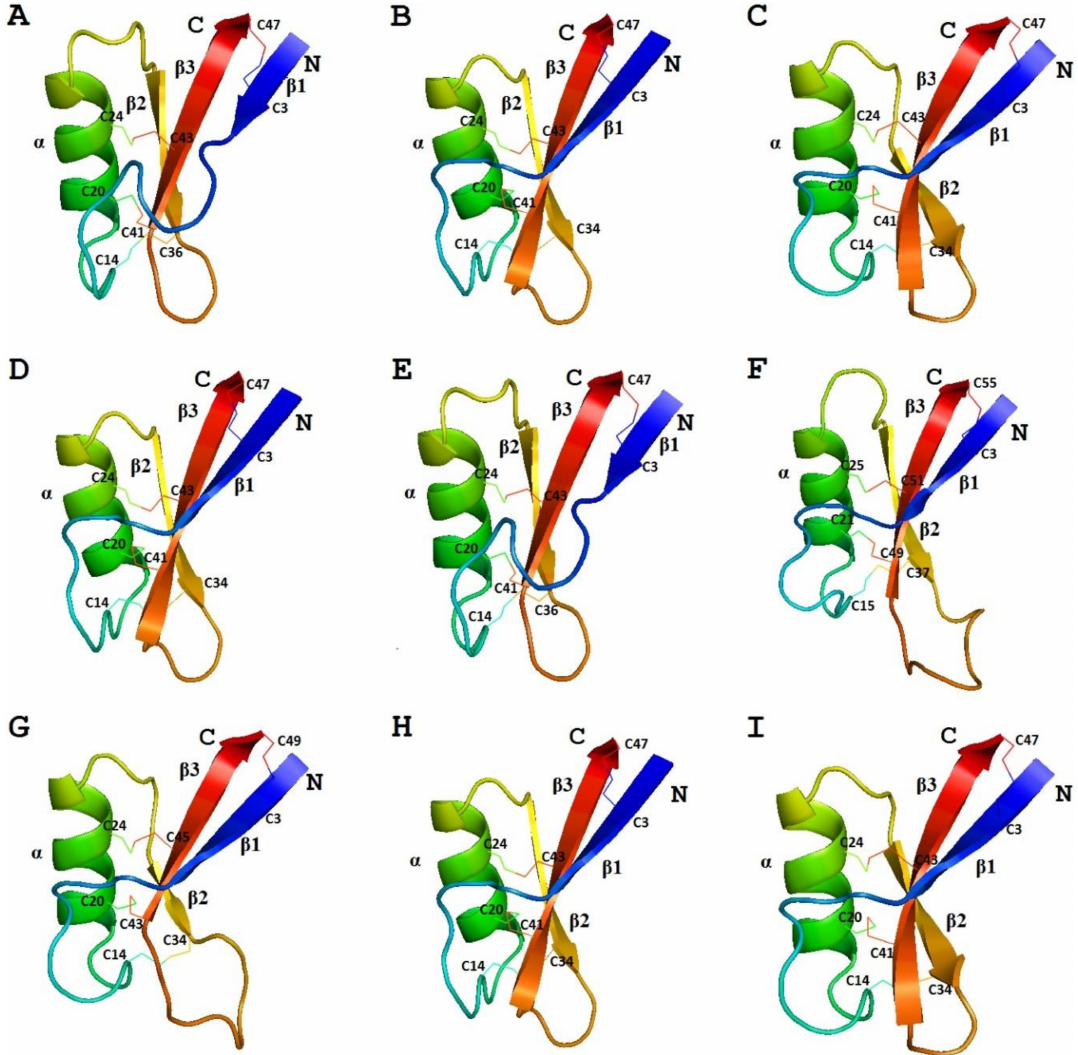
Figure 4. The 3D structure models of sorghum defensins ( A ) Sialpha1 and ( B ) Sialpha2 with γ -hordothionin (PDB 1GPT) and γ 1 -purothionin (PDB 1GPS) as templates, respectively; rice defensin ( C ) OsDEF8withZmD32(PDB6DMZ)asatemplate; maizedefensins( D ) γ 1 -zeathioninwith γ 1 -purothionin (PDB 1GPS) as a template; ( E ) γ 2 -zeathionin and ( F ) ZMES1 with γ -hordothionin (PDB 1GPT) as a template; ( G ) ZmDEF1 with ZmD32 (PDB 6DMZ) as a template; lyme grass defensin ( H ) La-D4 with γ 1 -purothionin (PDB 1GPS) as a template; and barnyard grass defensin ( I ) Ec-AMP-D1 with ZmD32 (PDB 6DMZ) as a template. Modeling was carried out using SWISS-MODEL [91]. Disulfide bonds are shown by thin lines. The N-and C-termini are indicated by N and C, respectively. Secondary structure elements are denoted by α for α -helix and β for β